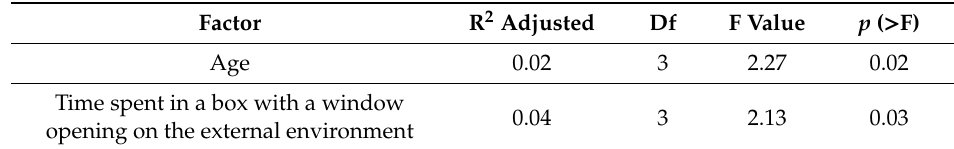
Table 4. Automatic stepwise building on the constrained ordination of behavioural indicators with 10,000 permutation tests. The forward model selection was carried out on adjusted R 2 and p -value with level accepted at p ≤ 0.05. The age and the presence in the box of an open window toward the environment had a significant e ff ect on the total behavioural variance.